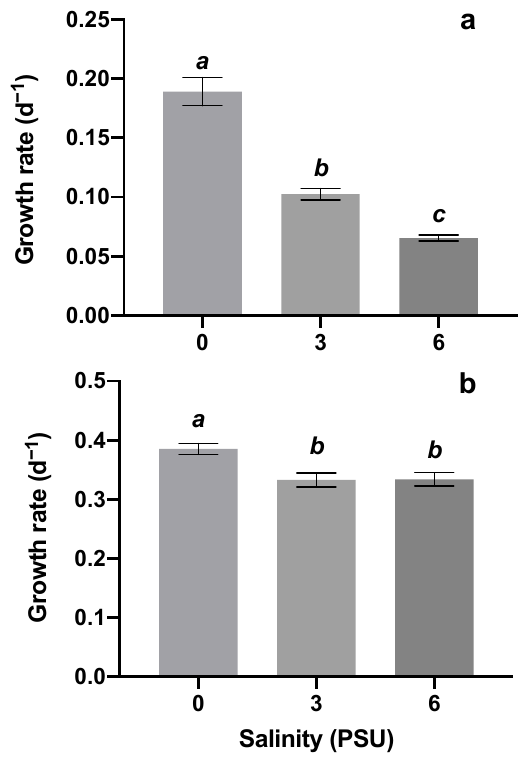
Figure 1. Growth rates of M. aeruginosa ( a ) and S. obliquus ( b ) in monocultures at three salinities (0, 3, 6). The values were presented as mean ± standard error. Lowercase letters in italic style represented significant differences caused by different salinities).